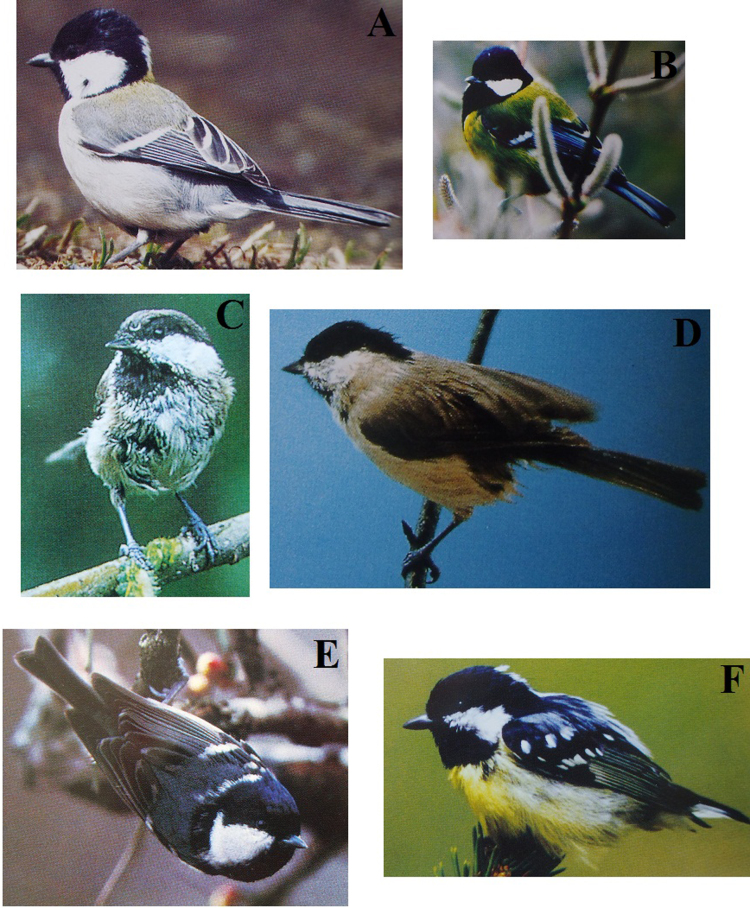
The figures of six tits species represented three sister groups. Note: A: P. major; B: P. monticolus; C: P. montanus; D: P. palustris; E: P. ater; F: P. venustulu.